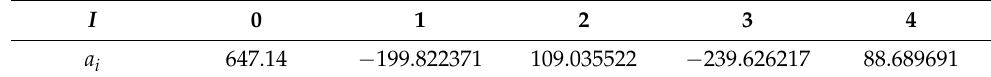
Table A4. Parameter a i for Equation